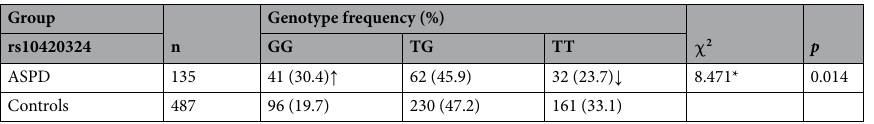
Table 1. Genotype frequency difference between the ASPD and control groups. ASPD antisocial personality disorder. *Intergroup comparisons were tested by chi-square test.